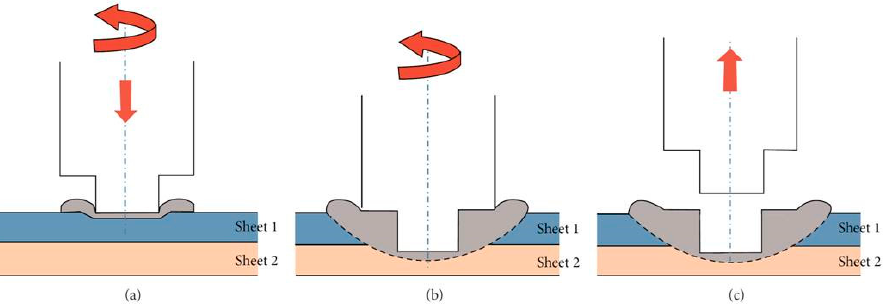
Figure 7. A FSSW process schematic of the tool actions steps. ( a ) Plunging while rotating, ( b ) dwelling after plunging to the specified depth, and ( c ) FSSW tool extraction [85].